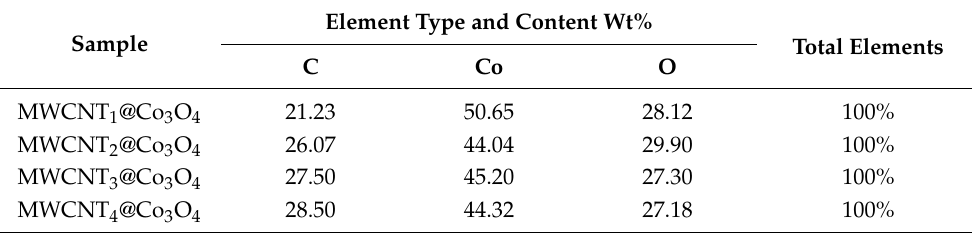
Table 1. Element content analysis of different compound ratios of MWCNT@Co 3 O 4 .